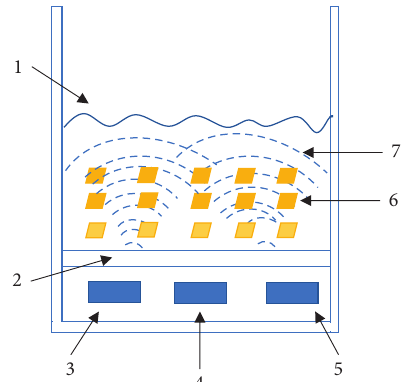
Figure 2: Ultrasonic pretreatment system. 1: deionized water; 2: ultrasonic generator; 3: temperature regulator; 4: time regulator; 5: power regulator; 6: sample; 7: ultrasonic